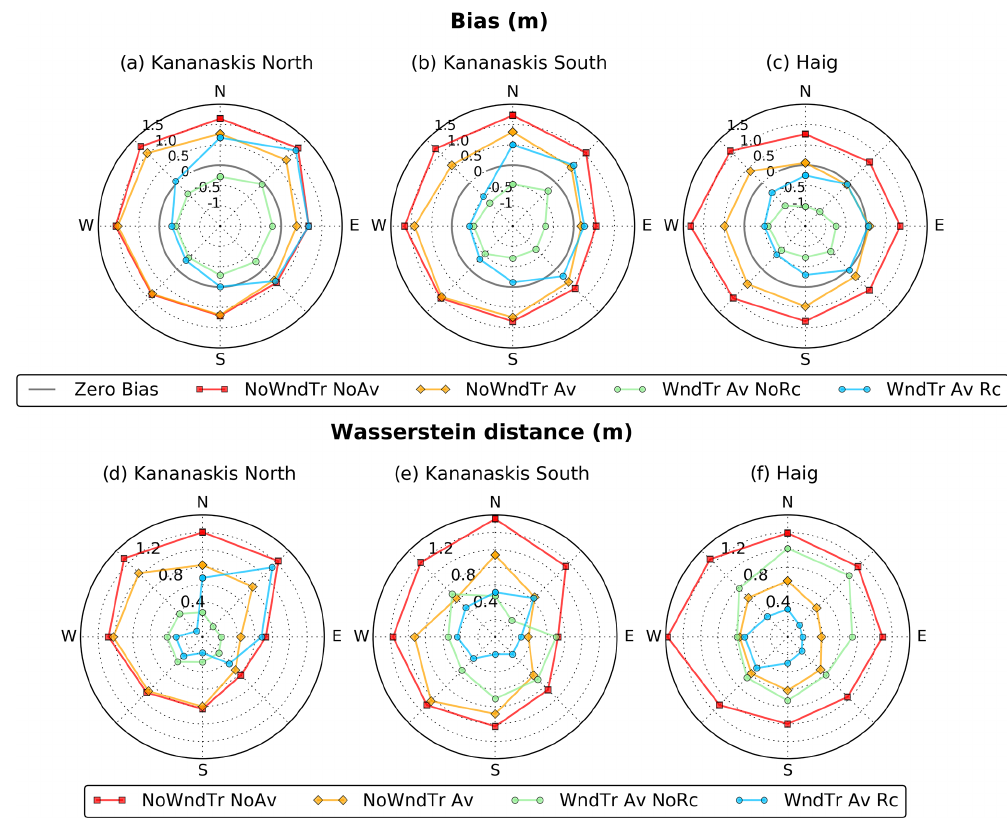
Figure 9. Bias (a–c) and Wasserstein distance (d–f) between observed and simulated snow depth distribution in upper slopes as a function of slope orientation for four CHM experiments and three sub-regions. The location of these sub-regions is shown in Fig. 1. Upper slopes are defined as regions of TPI larger than 150m (see Sect. 2.3.2). The thick grey circles on graphs (a–c) indicate a zero bias. Values outside this circle indicate a positive bias, whereas values within this circle indicate a negative